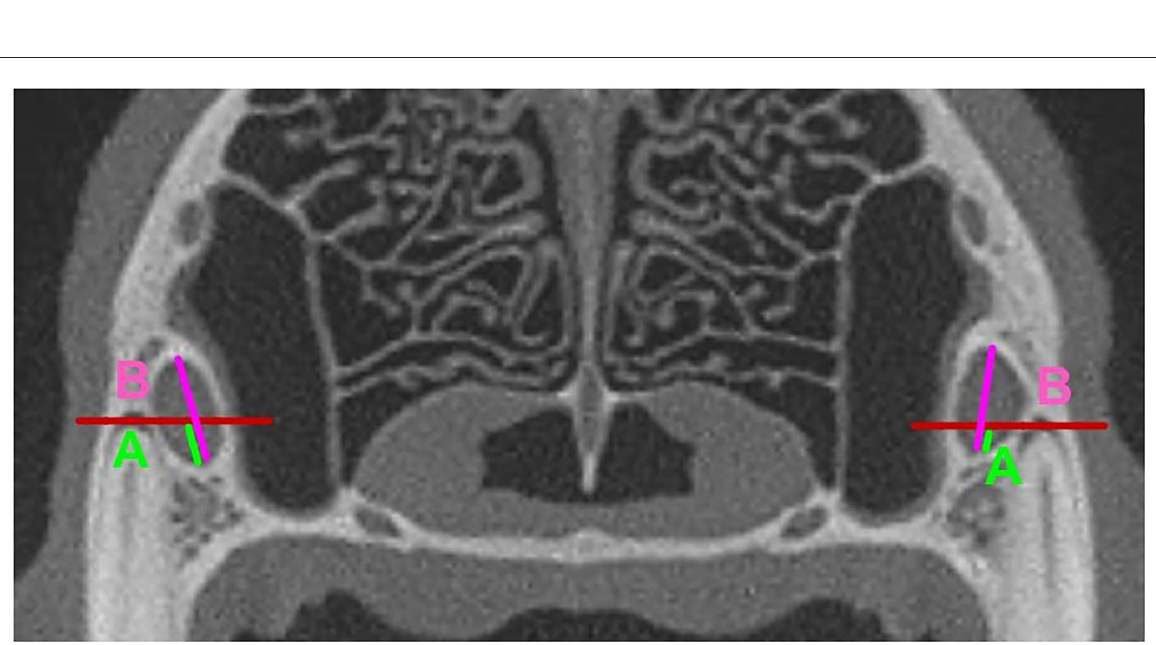
FIGURE5 Distal Roots of the P4. (A) (neon Green): Vertical Height of the portion of the IOC in Section 12. (B) (fuchsia): Total Vertical height of the IOC. The portion (ratio) of the IOC in Section 12 was calculated as